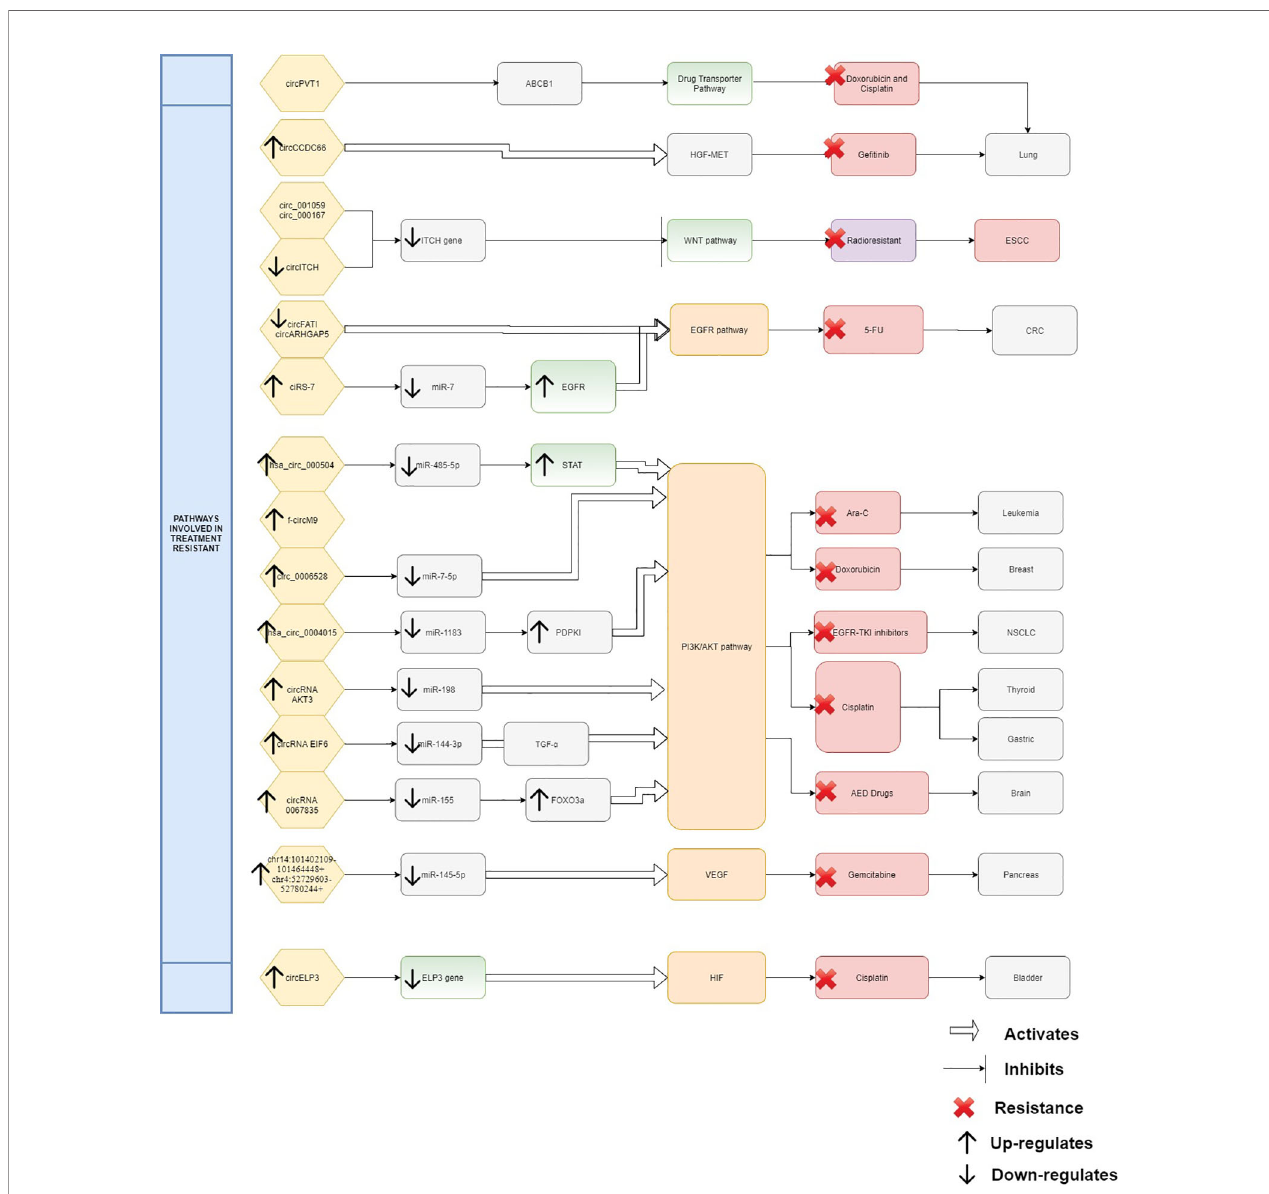
FIGURE 1 | Interaction between circRNAs, targeted gene, and